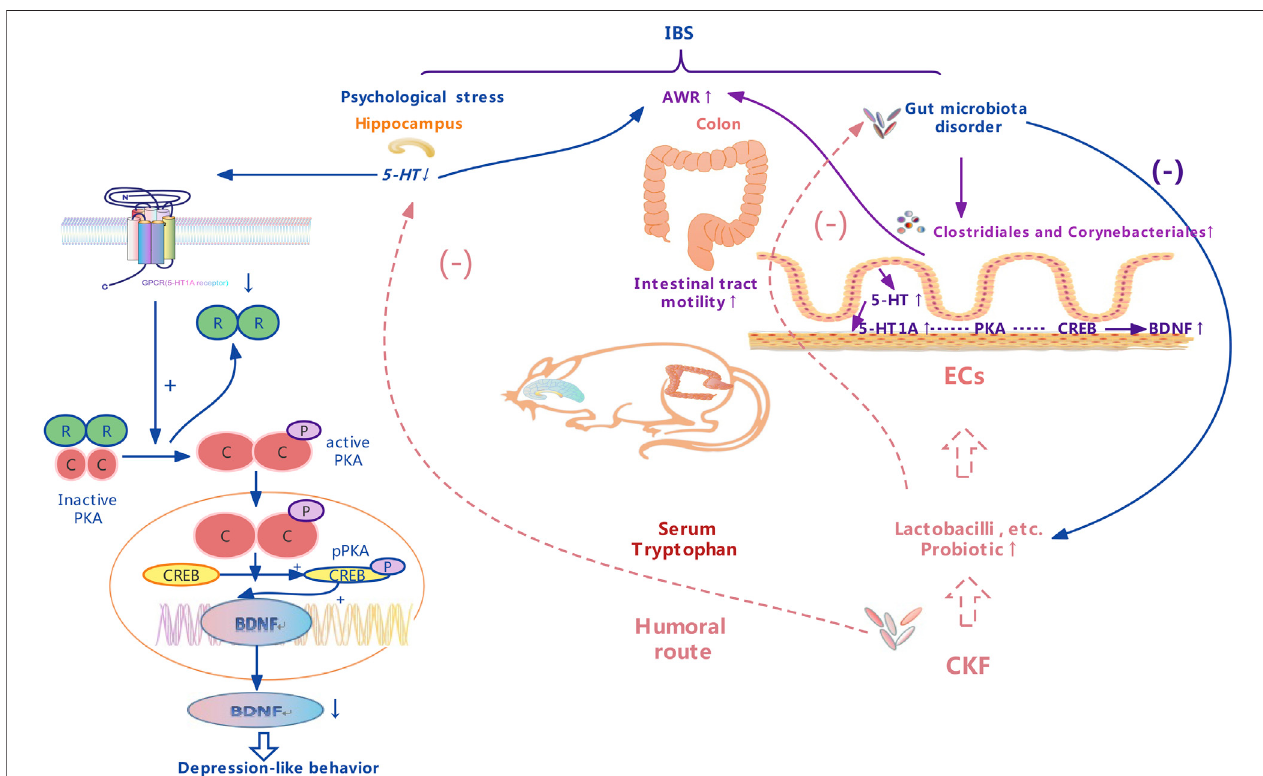
FIGURE 3 | A schematic representation of therapeutic effects of the Chang-Kang-Fang formula on the microbiota-gut-brain axis.